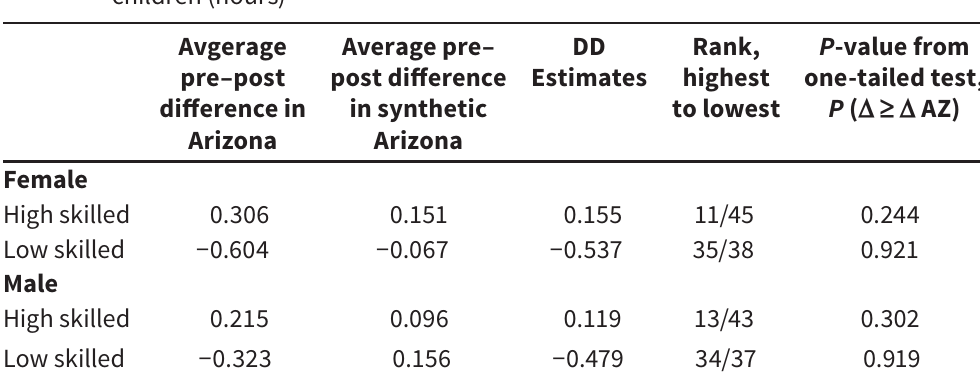
LAWA and native daily time spent on housework, gardening, and caring for children